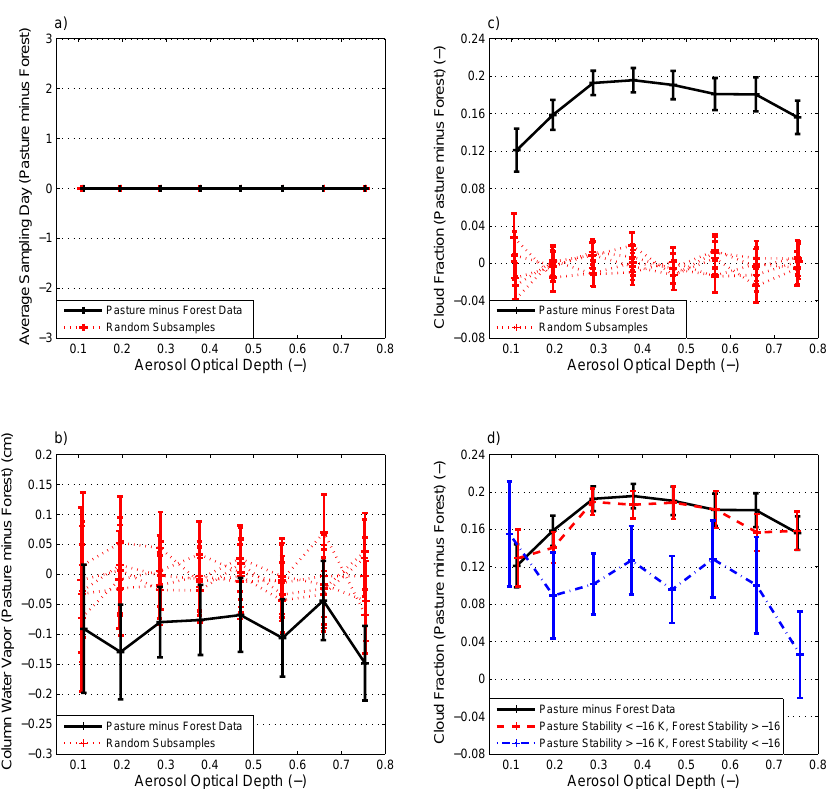
Fig. 8. (a) Difference between the average sampled day of the year in each AOD bin for the pasture and forest sites. (a) , (b) and (c) , dotted red lines represent the results of five random subsamples, where retrievals over forest and pasture are mixed. Data represent the months of August through October, for the years 2004 through 2007. (b) Differenced column water vapor binned by AOD between pasture and forest land cover types. (c) Differenced cloud fraction binned by AOD between pasture and forest land cover types. (d) Solid black line: same as (c) , dashed red and dash-dotted blue lines: differenced cloud fraction binned by AOD stratified by low-level stability, defined as the temperature at 850hPa minus the temperature at 1000hPa. The stratification values are different between pasture and forest for each stratification case. The number of retrievals included in each bin is provided in Supplement